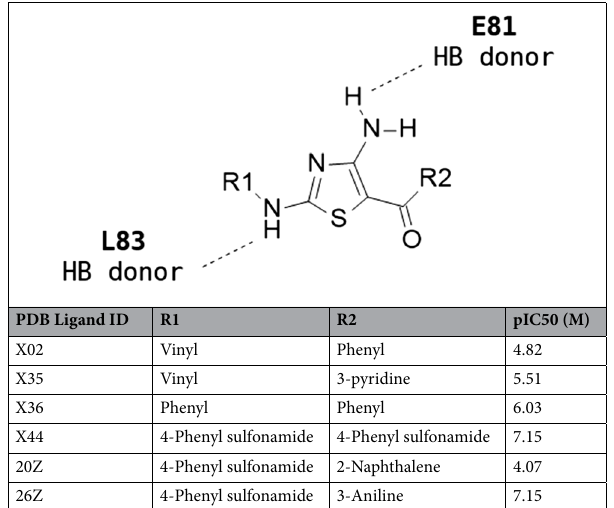
Table 1. The aminothiazole scaffold shared across the selected ligands, their R1 and R2 substituents, PDB ligand identifiers, and CDK2 pIC50s from ChEMBL. The aminothiazole scaffold also describes the primary and secondary amine hydrogens responsible for the interaction with the residues E81 and L83, respectively. The interaction between these hydrogens and the CDK2 receptor is suggested to be shared across all the selected ligands 22 .